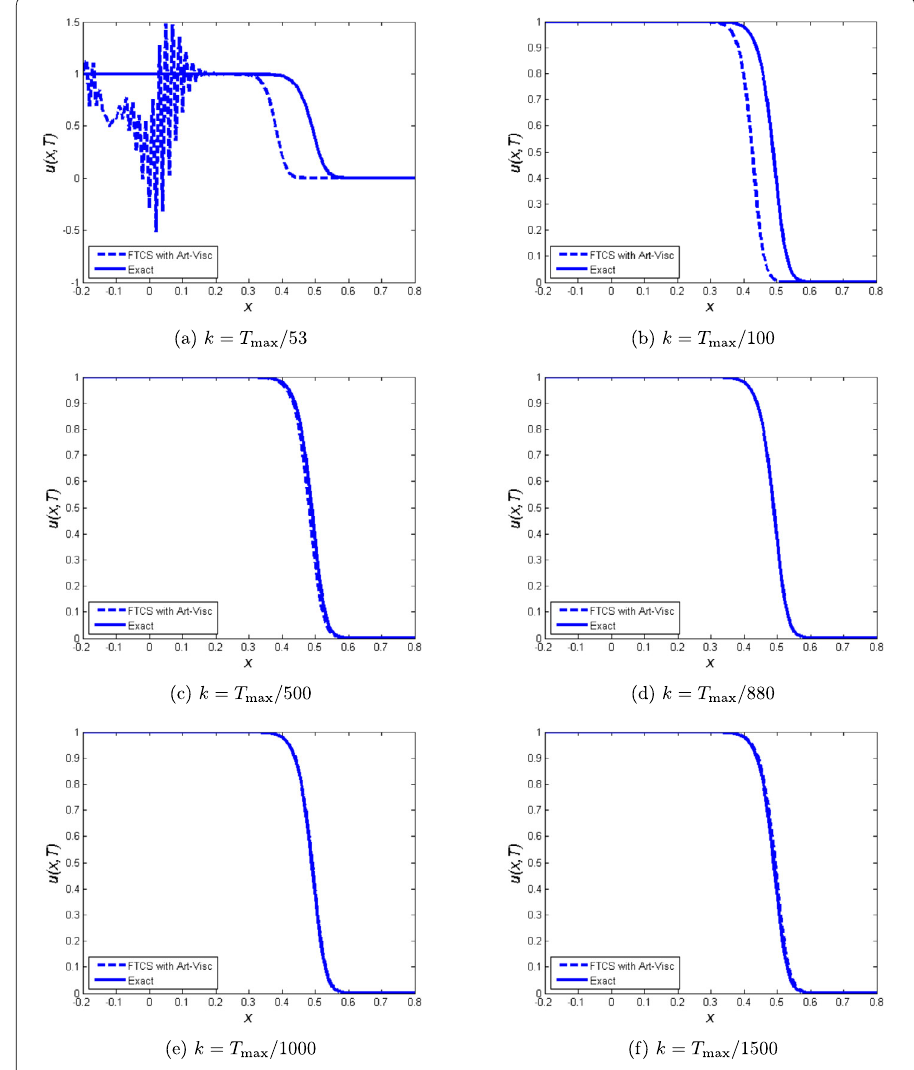
Figure 5 Plot of u against x for Problem 1 using FTCS with artificial viscosity at time 2.5 × 10 –3 at some different values of k and h = 0.01, σ = 2.0, T max = 2.5 × 10